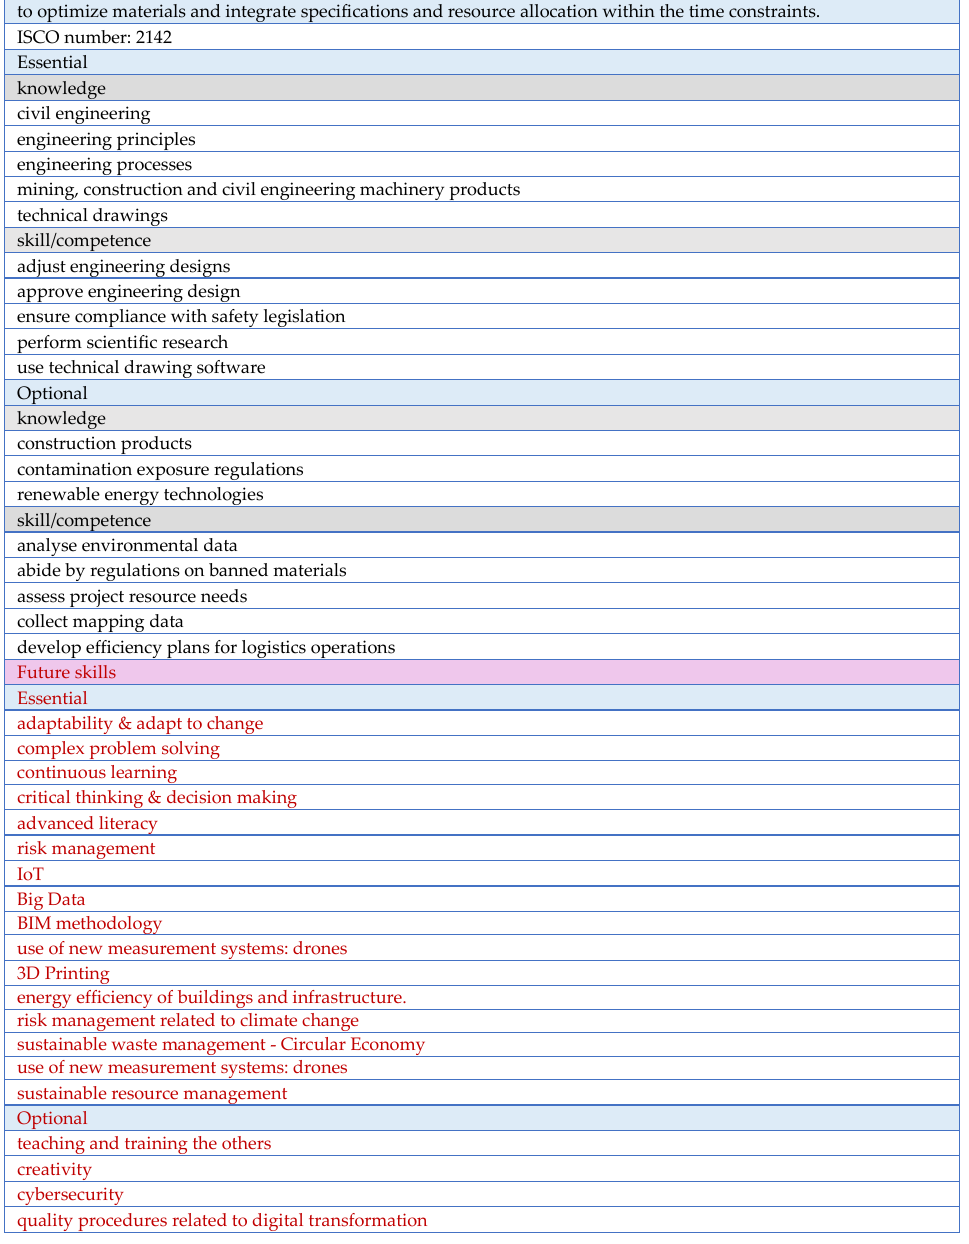
Figure 2. An example tab of the automated database generated for the job profiles related to the civil engineering